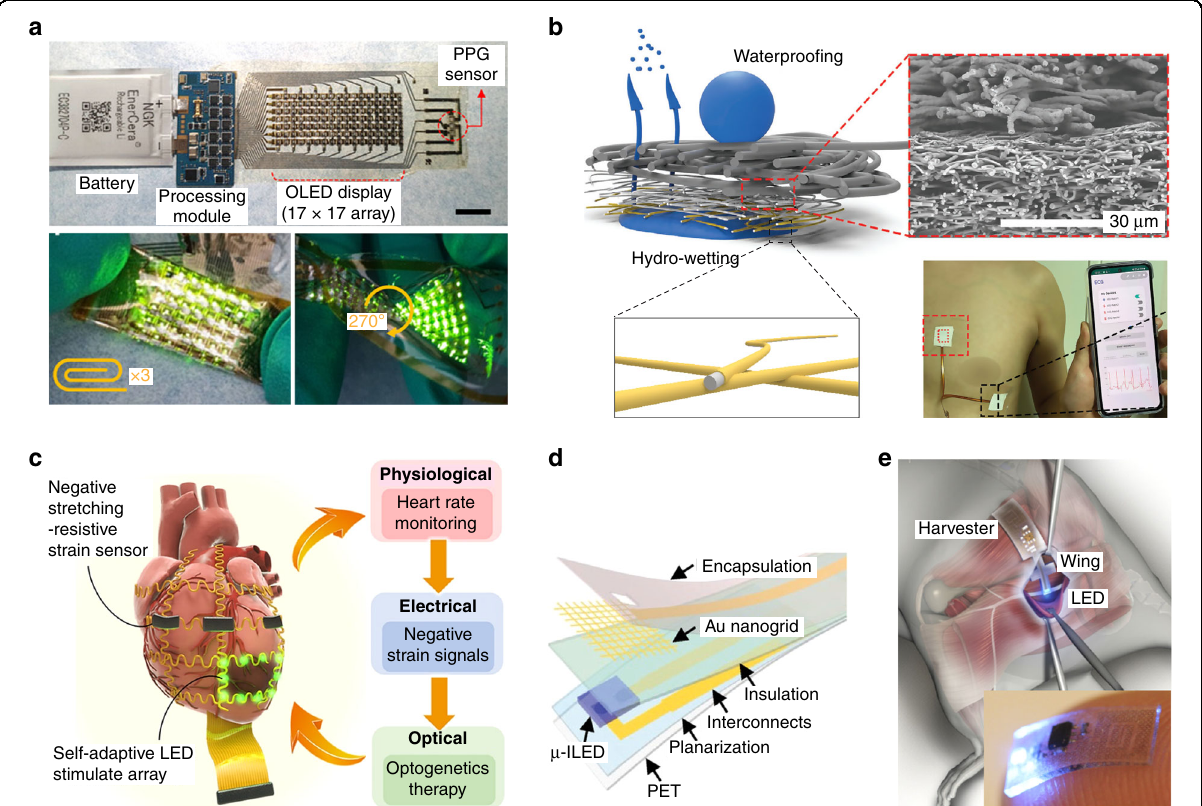
of permeable Au nano fi ber mat with both waterproo fi ng and hydro-wetting properties. Reproduced with permission from ref. 69 Copyright 2022 Wiley-VCH. c Cardiac optogenetics therapy composed of strain sensors for heart rate monitoring and self-adaptive LEDs for optical stimulation. Reproduced with permission from ref. 74 Copyright 2021 AAAS. d , e Use of implantable optoelectronic devices for wireless optical stimulation ( d )